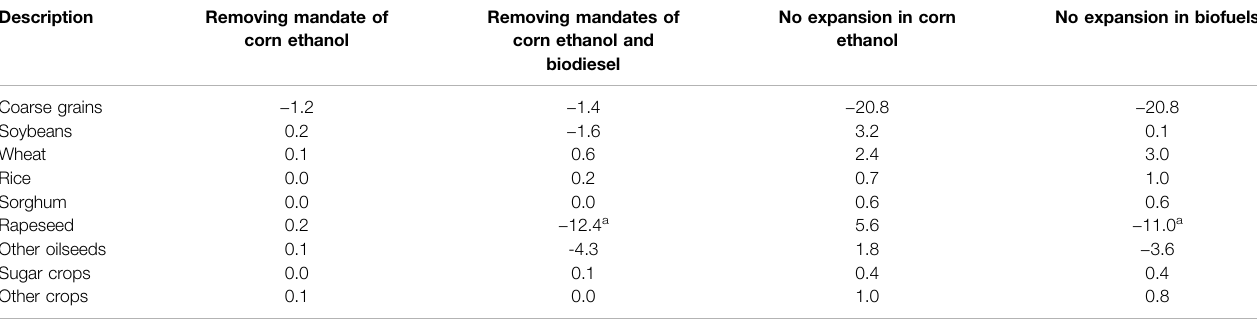
TABLE 1 | Percentage change in crop outputs under alternative examined counterfactual experiments for 2004 – 2011. Description